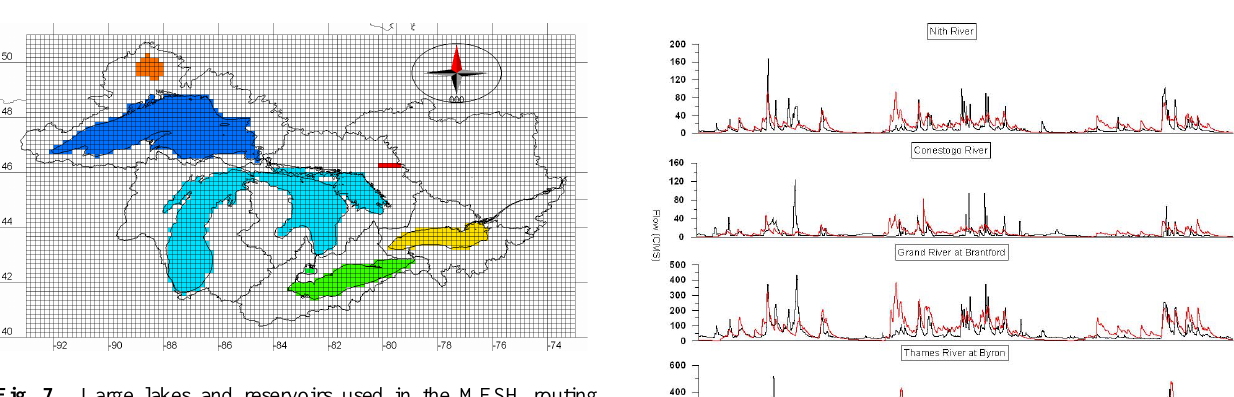
Fig. 7. Large lakes and reservoirs used in the MESH routing scheme.